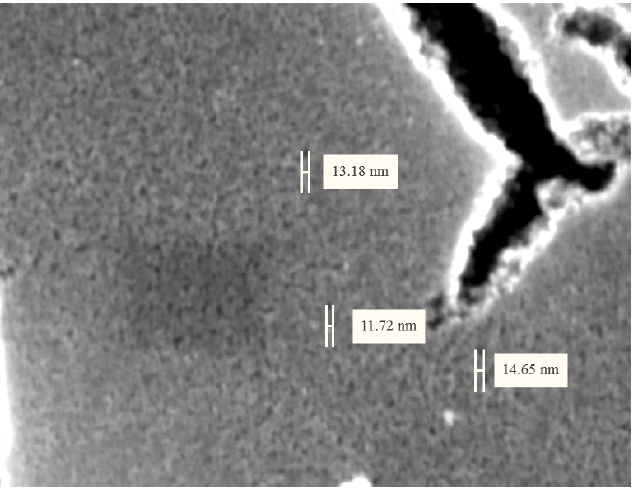
Figure 5. High-resolution electronic microphotograph of the sample after 4 cycles of dip coating.